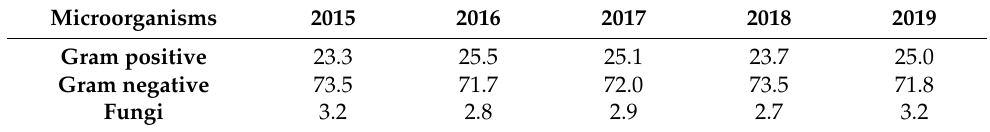
Table 4. Subdivision of microorganisms isolated from positive samples expressed in